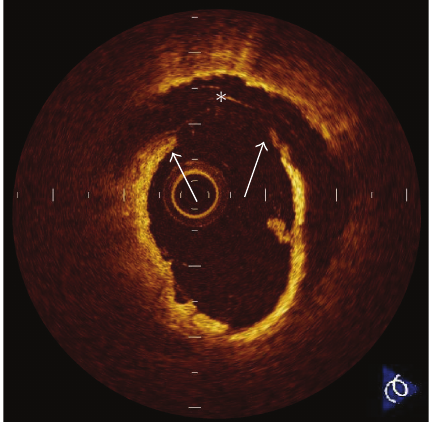
Figure 3: Intracoronary thrombus. Thrombus is defined as a protrusion inside the lumen of the artery with signal attenuation. White thrombus which consists mainly of platelets is identified as signal rich, low-backscattering protrusions in the OCT image, while red thrombus which consists mainly of red blood cells is identified as high-backscattering protrusions inside the lumen of the artery, with signal-free shadowing in the OCT image.